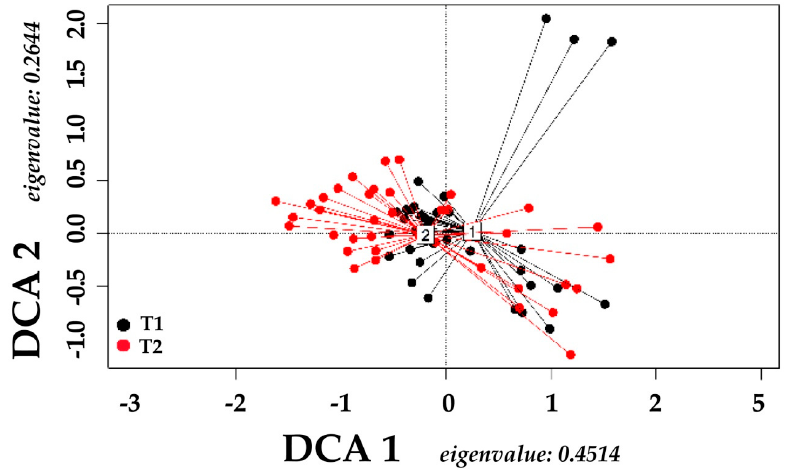
Figure 2. Detrended correspondence analysis using species as the explanatory variables. Black dots represent the relevés sampled in T1 (1992); red dots represent the relevés sampled in T2 (2016/2017); lines (blank and red) link the relevés with the respective centroids (numbered squares 1 and 2).